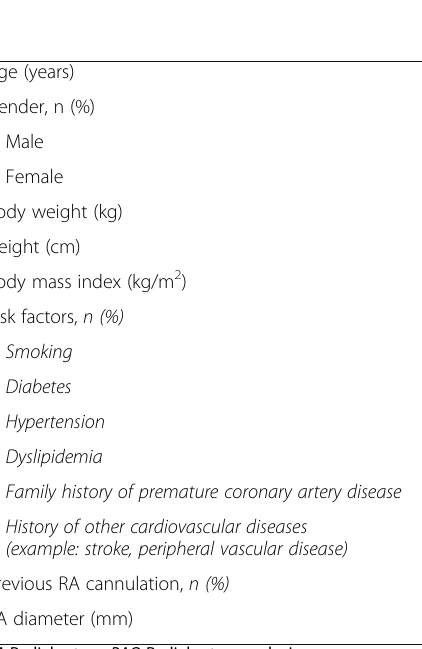
Table 2 Demographic and clinical characteristics of the study groups